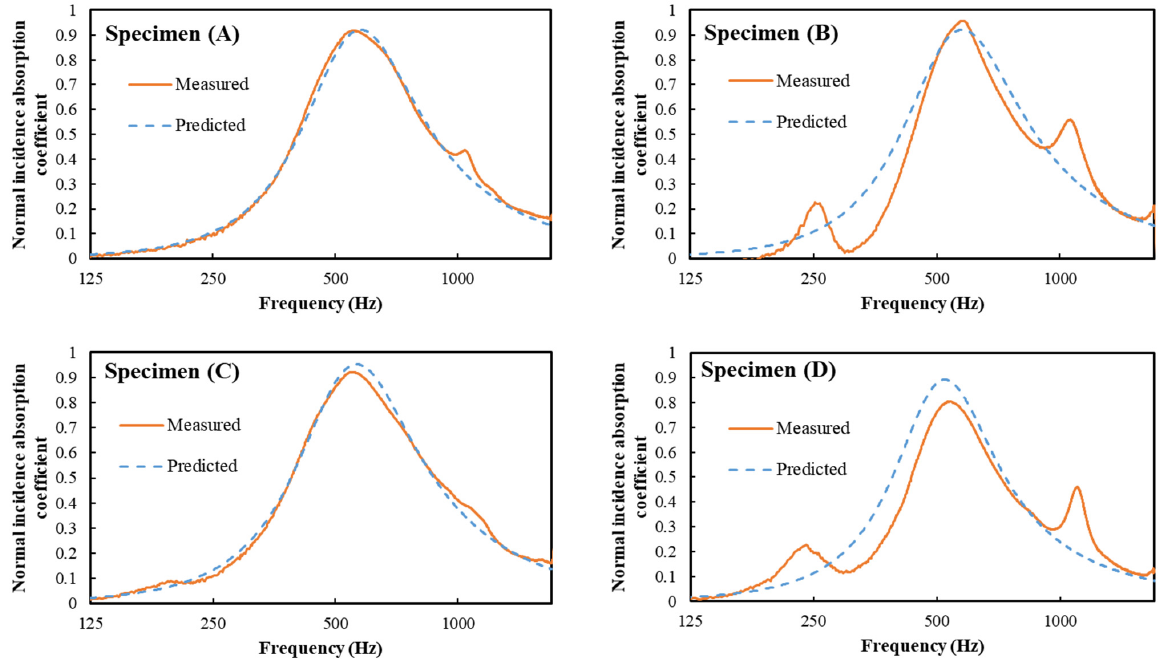
Figure 10. Measured results for the normal incidence absorption coefficient and their comparison with predicted values when the air cavity is 50 mm. Solid line: Measured; dashed line: Predicted. The parameters of Specimens (A), (B), (C) and (D) are detailed in Table 1 and Figures 1–4.